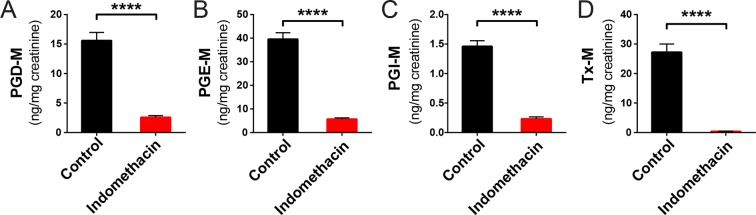
Inhibitory effects of chronic indomethacin treatment on COX-1 and COX-2 in C57BL/6 mice.Mice were receiving control diet (black) or indomethacin diet (20 ppm, red) for 7 days and urine were collected for the analysis of prostanoid metabolites. PGD-M (A), PGE-M (B), PGI-M (C), and Tx-M (D) are reduced in indomethacin-treated mice. N=10/group. ****p<0.0001 by Mann-Whitney test, multiplicity adjusted. Mean ± S.E.M. shown.